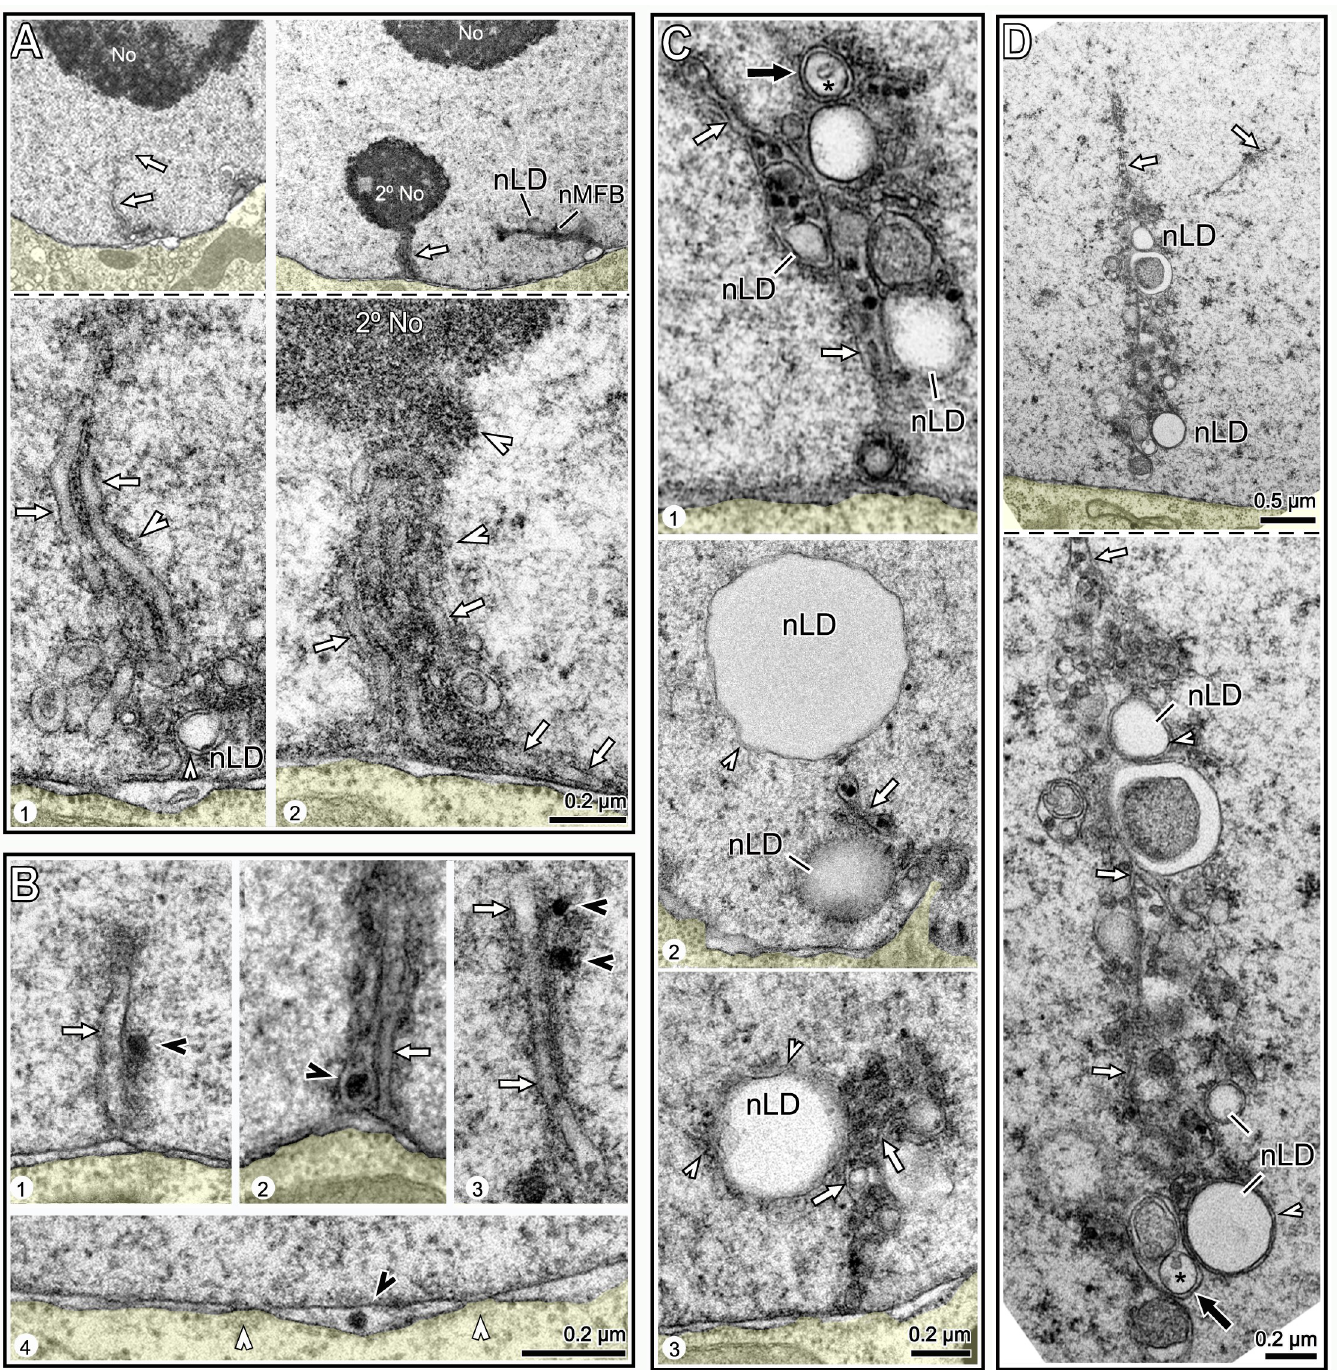
Fig 4. Intestinal nuclei contain a type I nucleoplasmic reticulum. (A) Examples of nuclear tubules (arrows) that appear to extend from the nuclear envelope toward either the nucleolus (panel 1), or a secondary nucleolus (panel 2). Note that these tubules are surrounded by fine granular material (white arrowheads in insets). (B) Examples of nuclear tubules (arrows) that are associated with large, electron-dense granules (black arrowheads). Panel 4 shows an electron-dense granule in the perinuclear cistern between the INM and ONM; white arrowheads indicate nuclear pores (see S3 Fig for additional examples). (C) Examples of nuclear tubules (white arrows) associated with nLDs, some of which contain electron-dense granules (see also S3 Fig). White arrowheads in panels 2,3 indicate membrane fragments at the periphery of some nLDs. The black arrow in panel 1 indicates a nested vesicle as described below. (D) TEM of a D3 nucleus at low (top) and high (bottom) magnification showing a linear cluster of tubules (white arrows), nLDs and vesicles. White arrowheads and black arrow as for Fig 4C . Scale bars in microns as indicated.